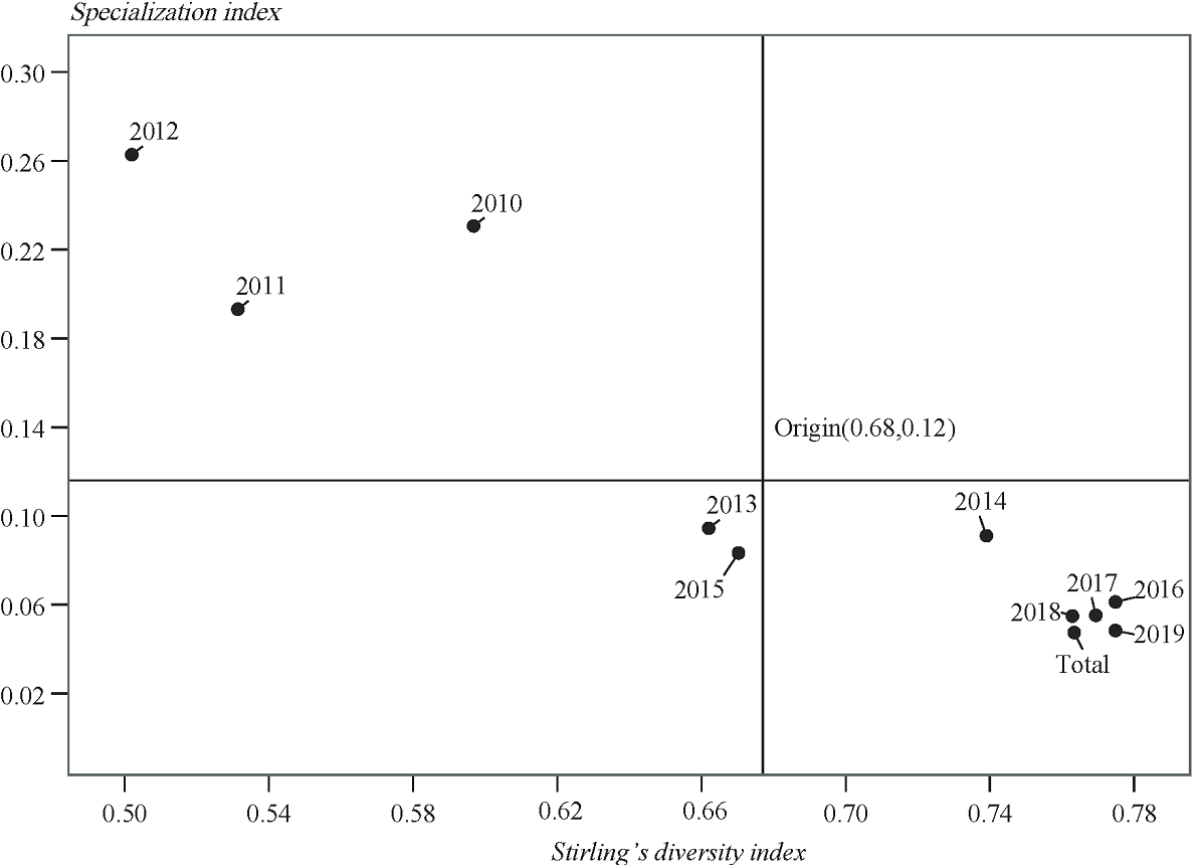
Figure 7. The relative status of interdisciplinarity for each year and all years